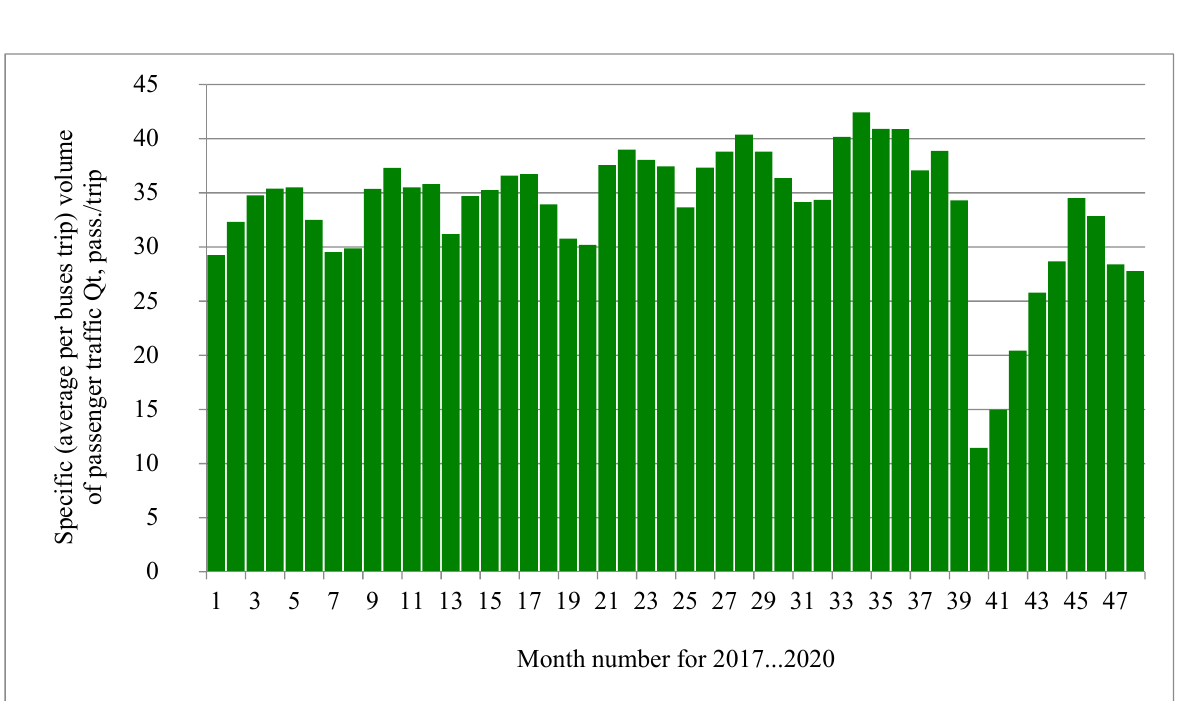
Figure 4. Dynamics of change of specific (per trip) value of transportation volume, Q trip of the Tyumen CPPT during 2017–2020 (4 years).